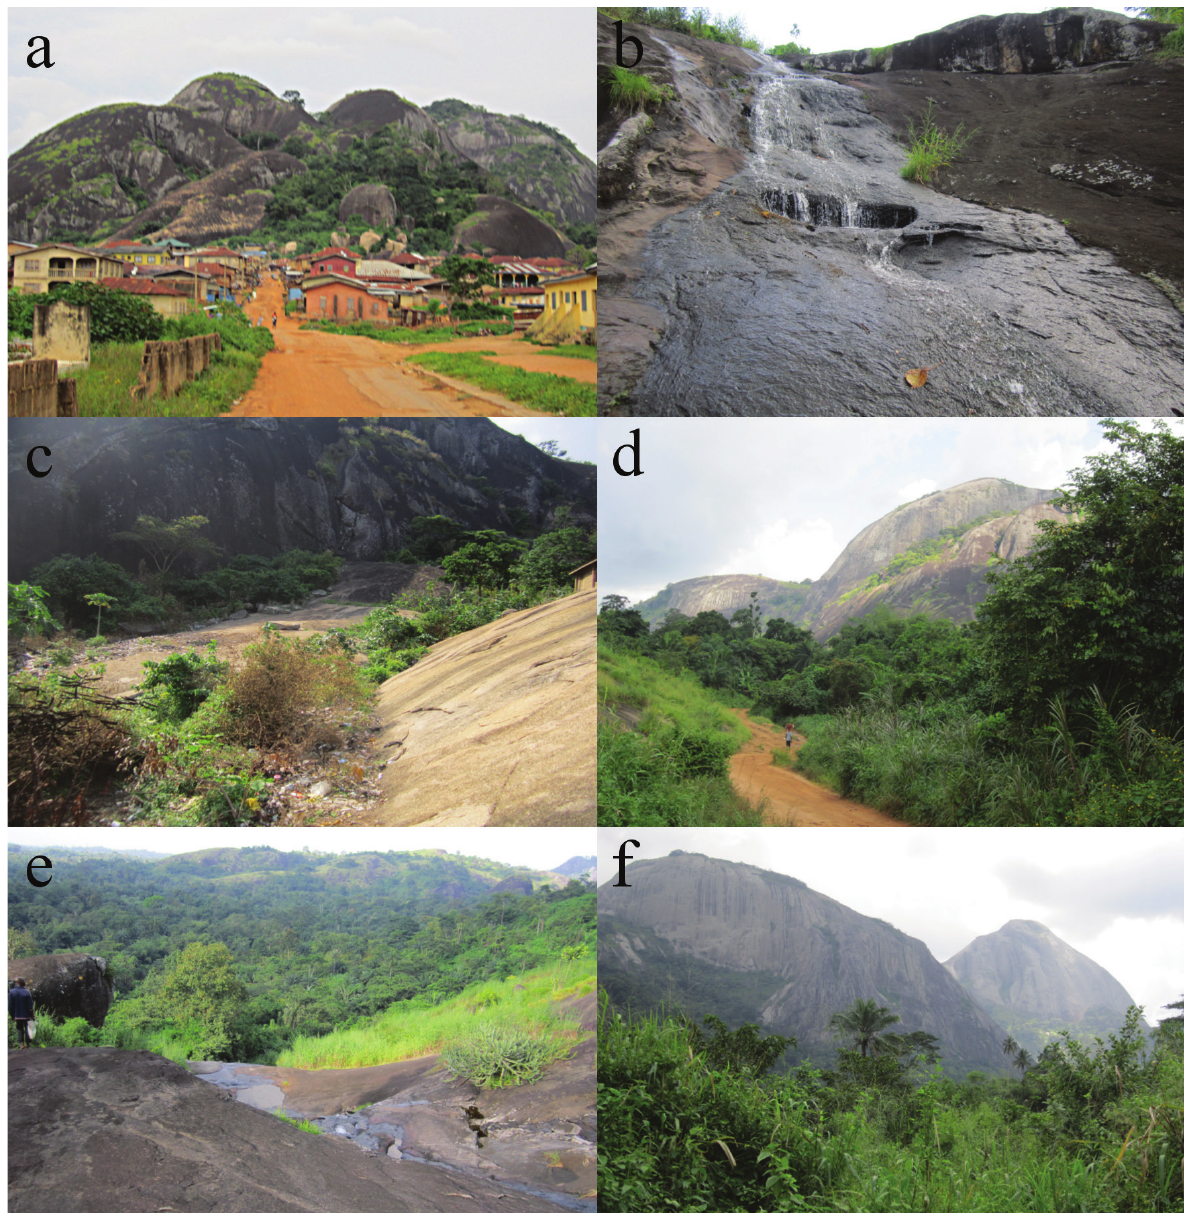
Figure 2. The Idanre Hills inselbergs in south-western Nigeria (a-f), the type locality and only known habitat of Amietophrynus perreti . Survey site A was only about 50 m from the last house in a; b: figures a overflown part of rock at site B; c: some A. perreti were observed close to the waste dumping site (left at the rock base), probably feeding on flies or other insects; d: a road leading to Site C, the cocoa farm being further in the background adjacent to the large rock; e: part of site C. Table 1. Time period and time span spent searching for Amietophrynus perreti per site in the Idanre Hills. In parenthesis total search time per site is given in person-hours.